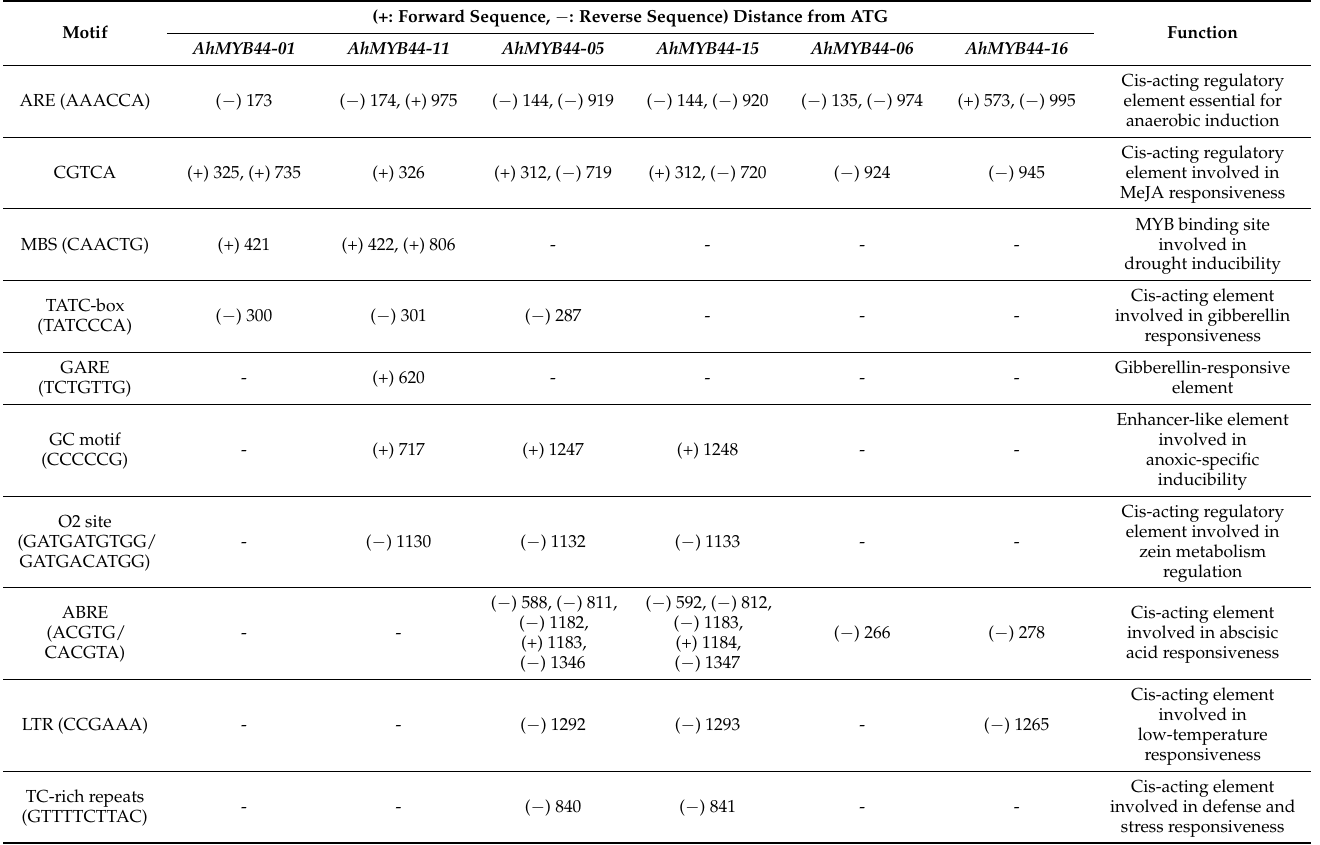
Table 2. Motif elements potentially associated with the stress response of AhMYB44s